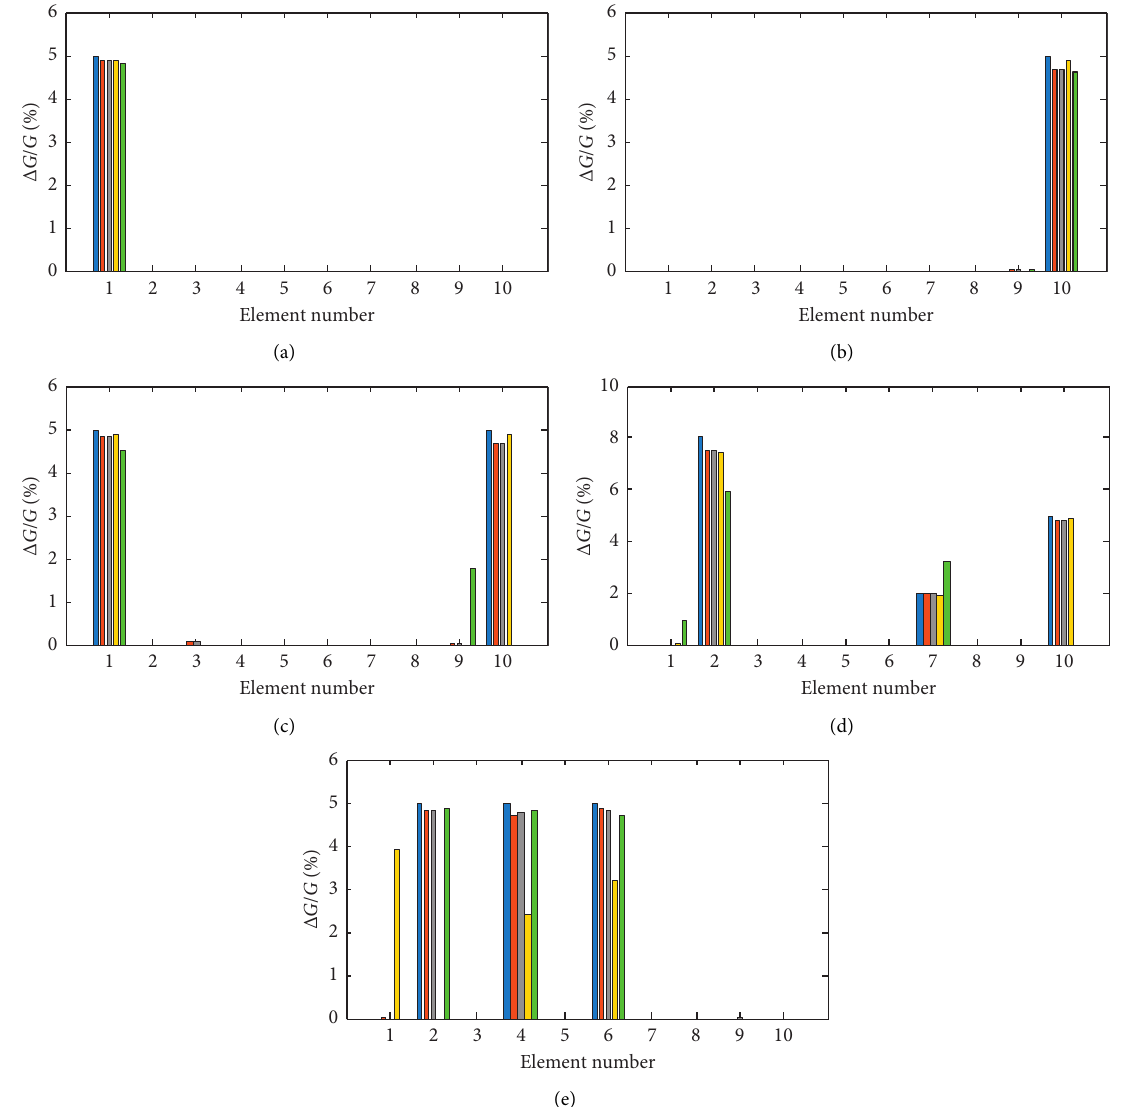
Figure 7: Detection of Cases 1–5. Actual damage; identification result (Scheme 3); identification result (Scheme 4); identification result (Scheme 5); identification result (natural frequencies).